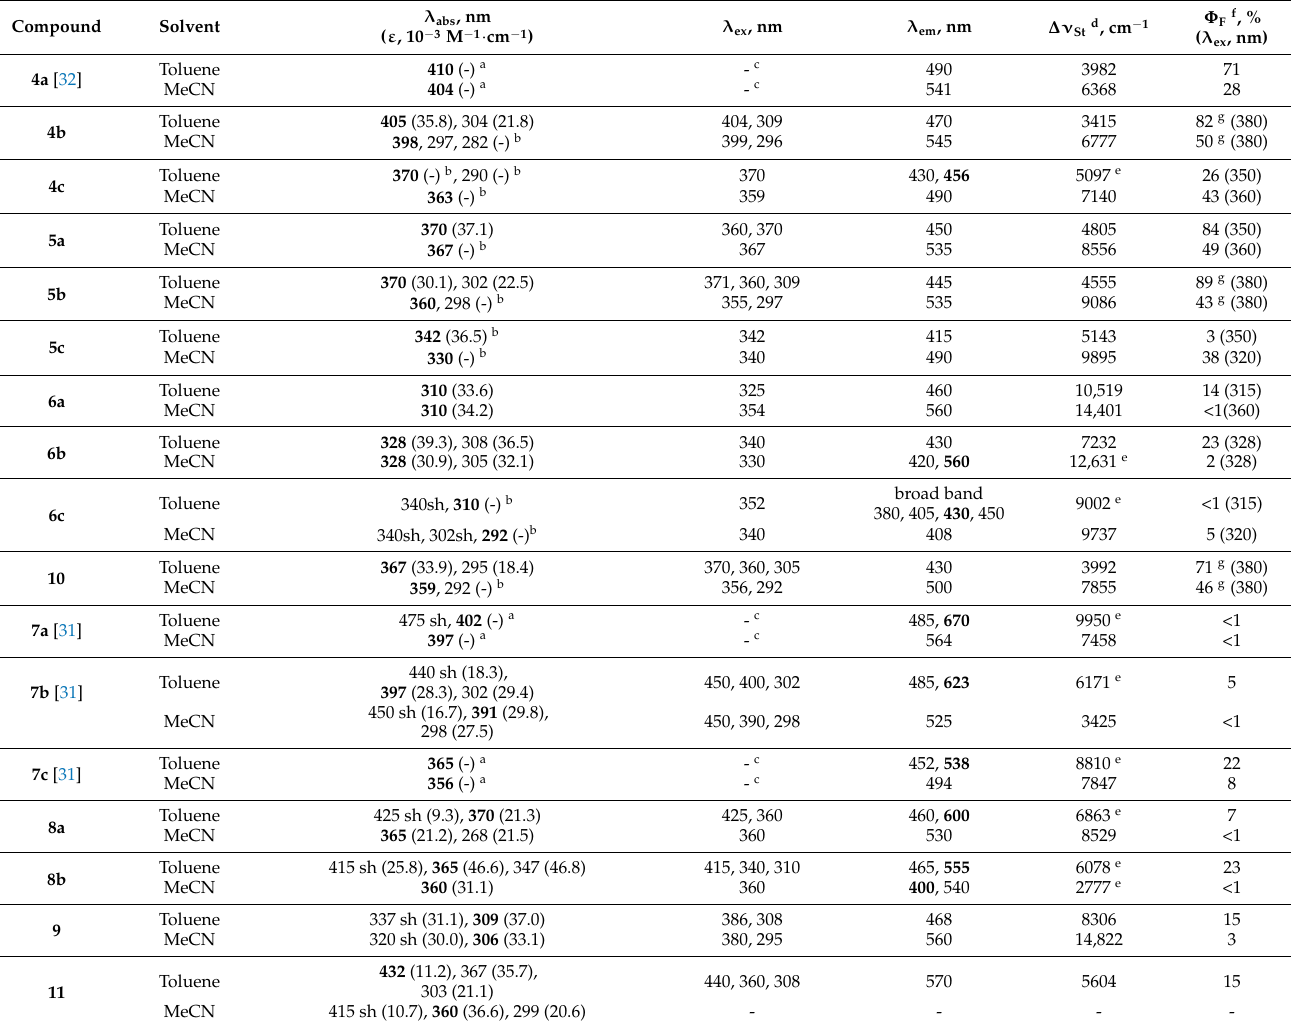
a Not calculated. b Poor solubility. c Not measured. d Stokes shifts were calculated considering the lowest energetic absorption band (in bold). e Relative to major emission maximum (in bold). f Fluorescence quantum yield was determined relative to quinine sulfate in 0.1 N H 2 SO 4 as standard ( Φ F = 0.55). g Fluorescence quantum yield was determined relative to 3-aminophthalimide in ethanol as standard ( Φ F =